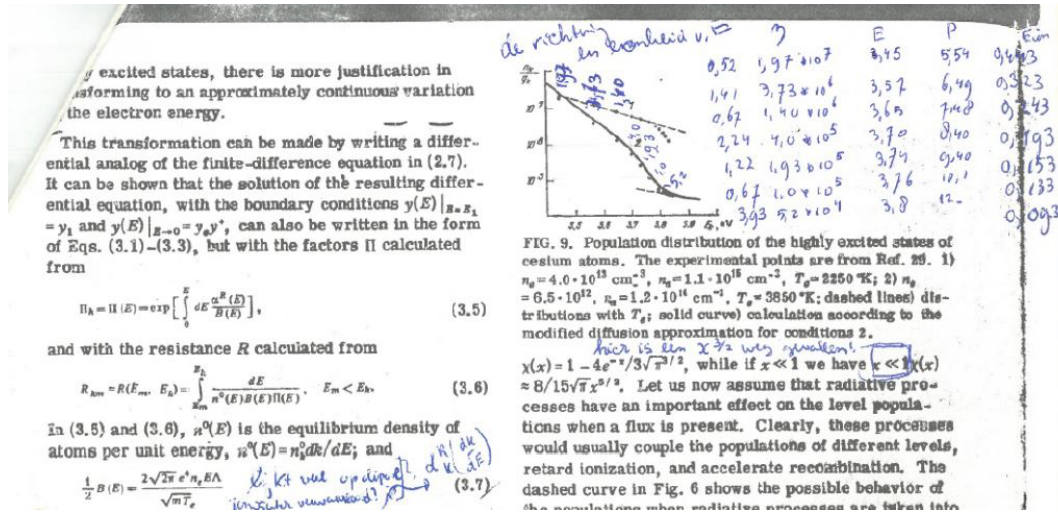
Figure 1. Example of a “traditional way” of retrieving data from a physically printed plot of a paper by Biberman et al. [14] which was itself scanned in the present case from a printed journal volume (courtesy from J. van Dijk,